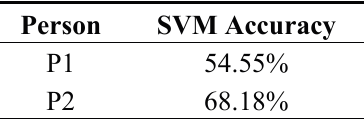
Table 4. Results of scoring (classification) from stroke patients as compared to scores assigned by a clinician.